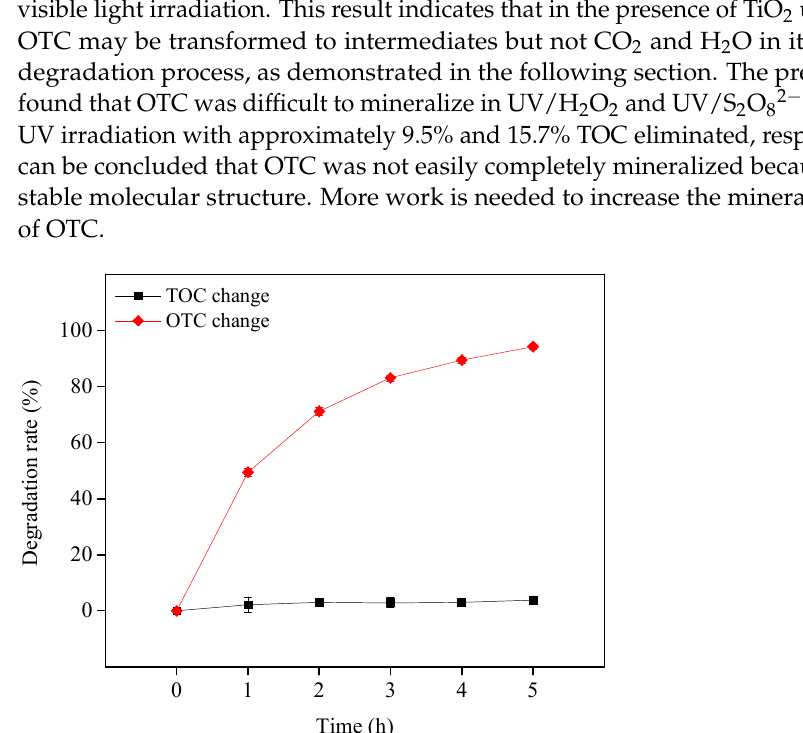
( b ) Figure 8. Evolutions of OTC transformation products by photolysis ( a ) and TiO 2 -assisted photosen- sitized degradation ( b ) under visible light irradiation at pH 8.6. Experimental conditions: [OTC] 0 = 10 mg L − 1 , [TiO 2 ] 0 = 0.5 g L − 1 , 50 mM phosphate buffer. In the photolysis and TiO 2 -assisted photosensitized OTC degradation under visible light at pH 8.6, direct degradation and O 2• − -mediated self-sensitized degradation were the